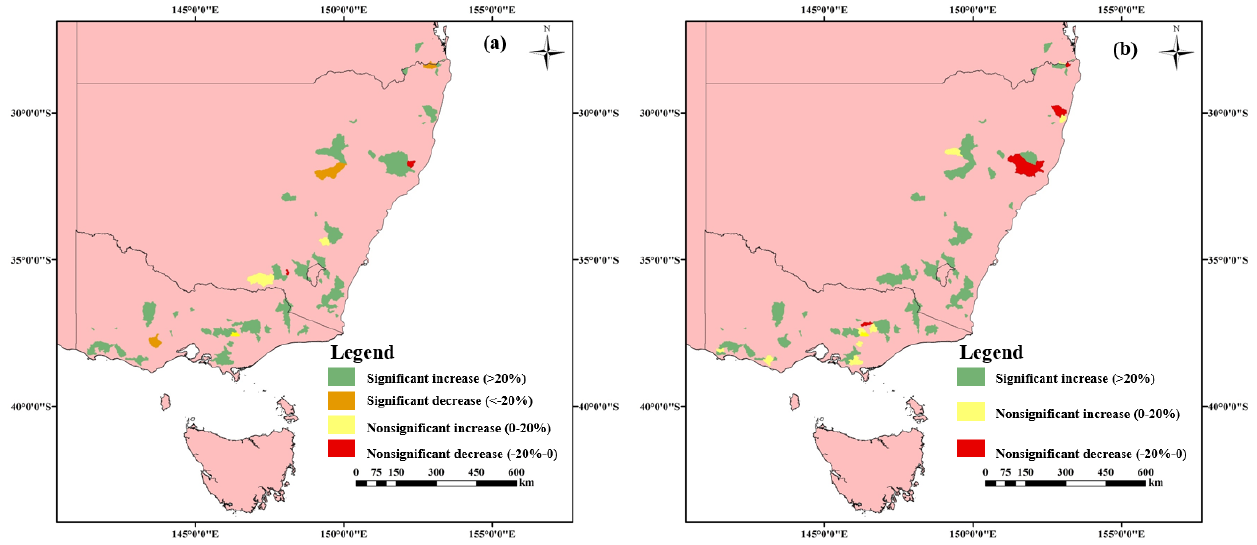
Figure 5. Spatial distribution of catchments with different change patterns in the ACWSC after prolonged drought. Panels (a) and (b) il- lustrate the spatial distribution of catchments with different variation forms in the amplitude α and mean value δ during the drought period,